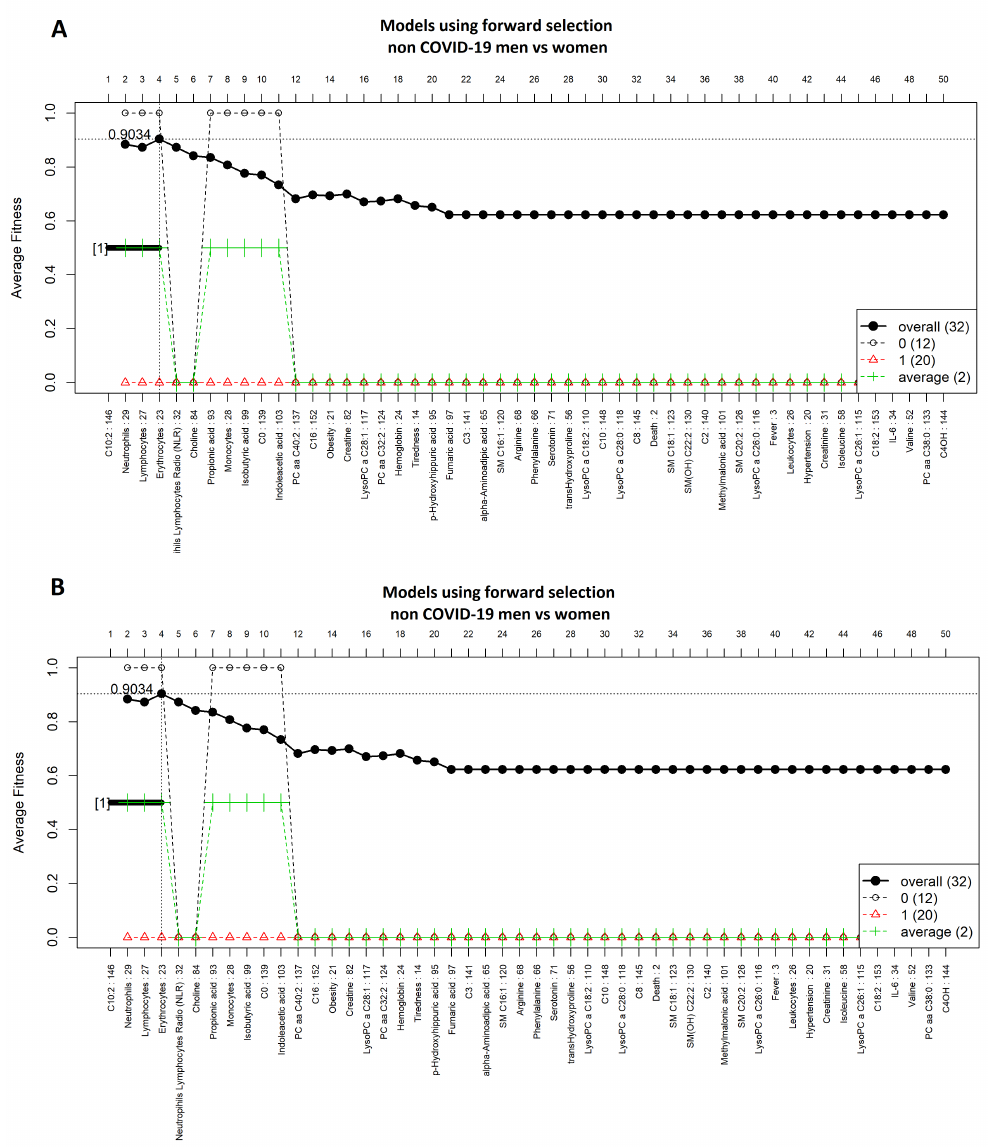
Figure A5. Forward selection model construction for classification of non-COVID-19 men and women ( A ) logistic regression and ( B ) support vector machine models. The vertical axis shows the classifica- tion accuracy. Solid line represents the overall accuracy calculated by measuring the misclassified samples divided by the total number of samples. Coloured dashed lines represent the accuracy per class [36]. The logistic regression function was computed using an external implementation coupled to the GALGO library; therefore, the dashed/average lines for this model could not be